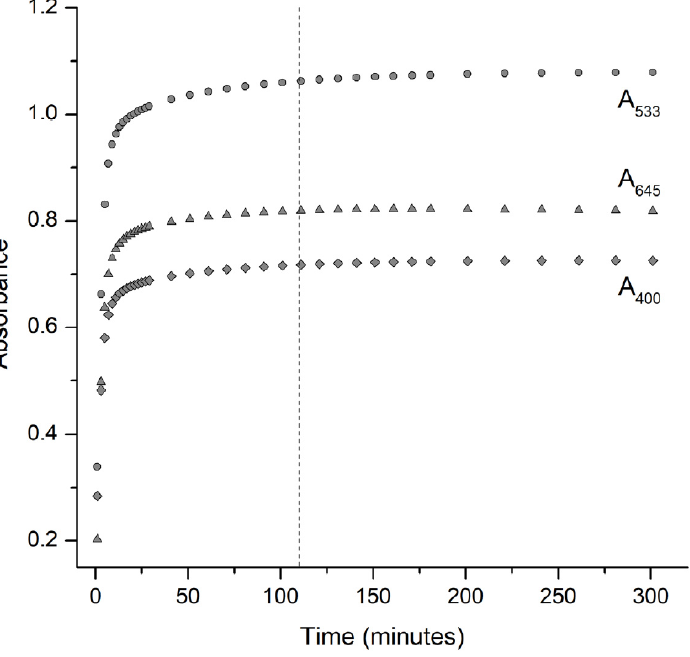
Figure 6. Kinetic curves representing the absorbance values at 400 nm (Au 0 ), at 533 nm (by-products), and at 645 nm (nanotriangles). The dashed line is indicating the growth process completion after 2